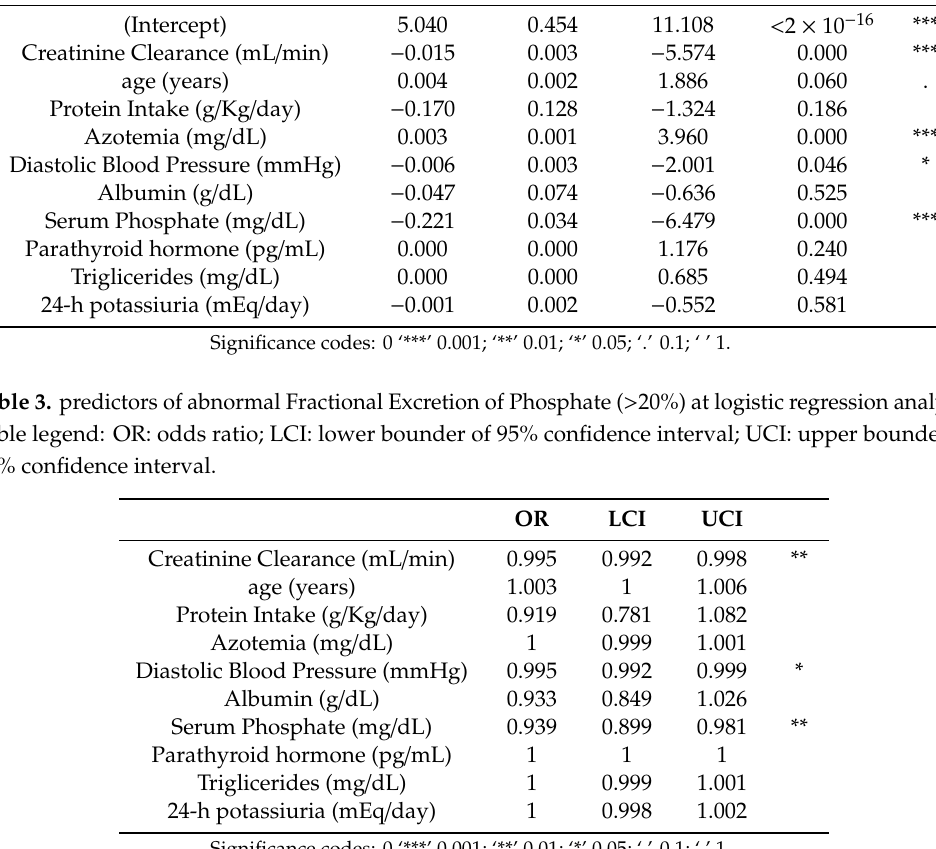
Table 2. predictors of Fractional Excretion of Phosphate (FeP) at linear regression analysis. Estimate